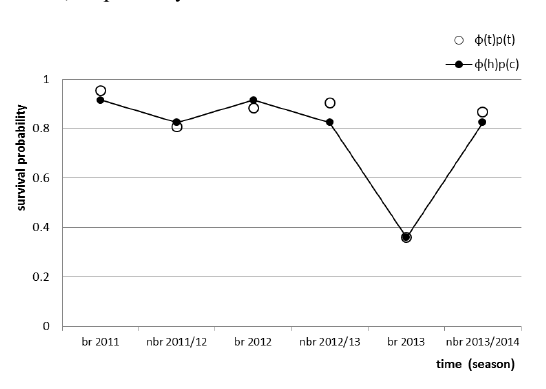
Fig. 2 . Seasonal survival probabilities of Black-headed Bunting ( Emberiza melanocephala ) according to the general model ( ɸ tpt) and the most parsimonious model ( ɸ hpc). Seasons are given as breeding (br) and nonbreeding (nbr) periods, comprising two and ten months,